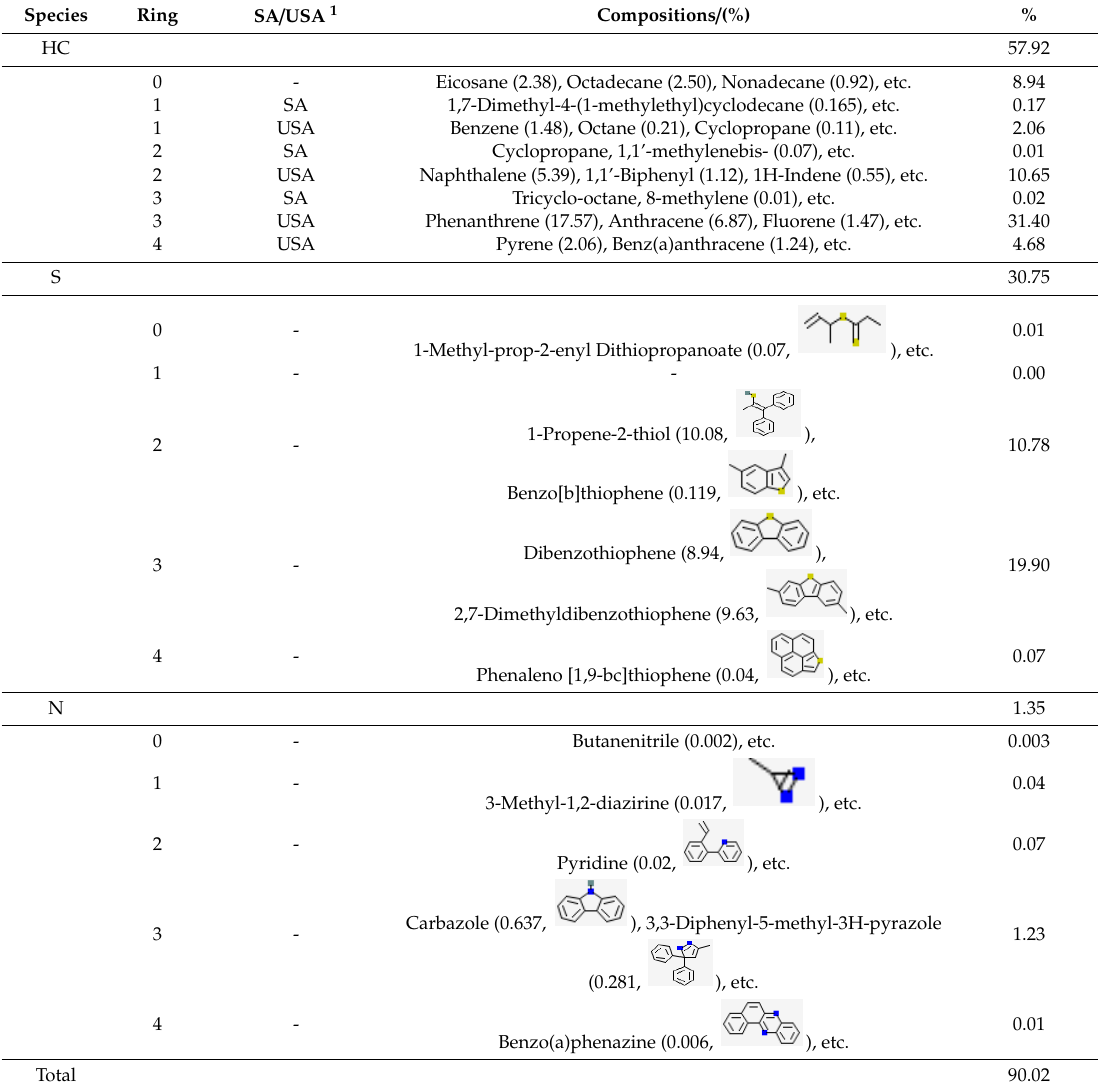
Table 1. Classified C, S, and N species of LCO feedstock.